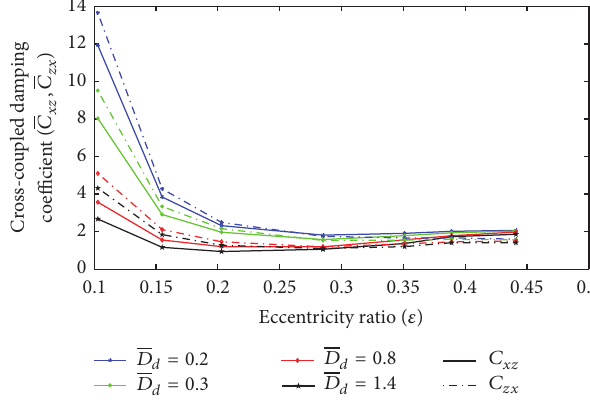
Figure 22: Effect of dam depth ratio on cross-coupled damping coefficient.